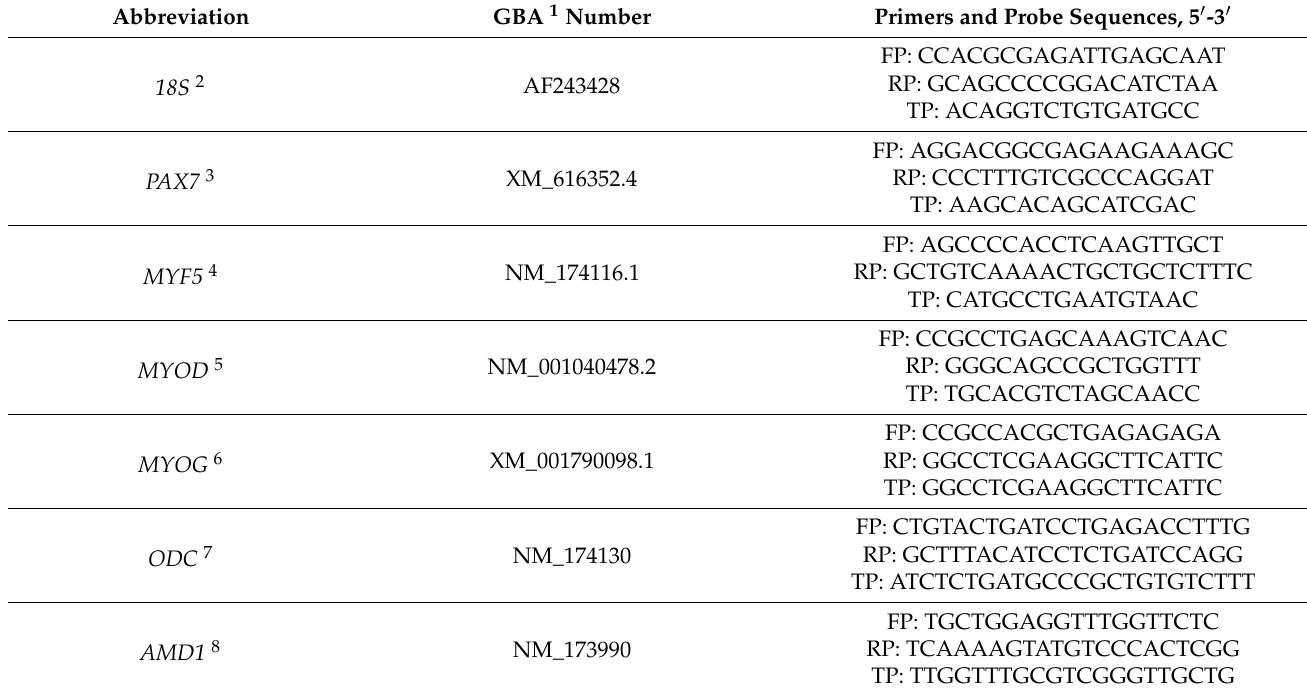
Table 1. Primer and Probe Sequences used in Real-Time